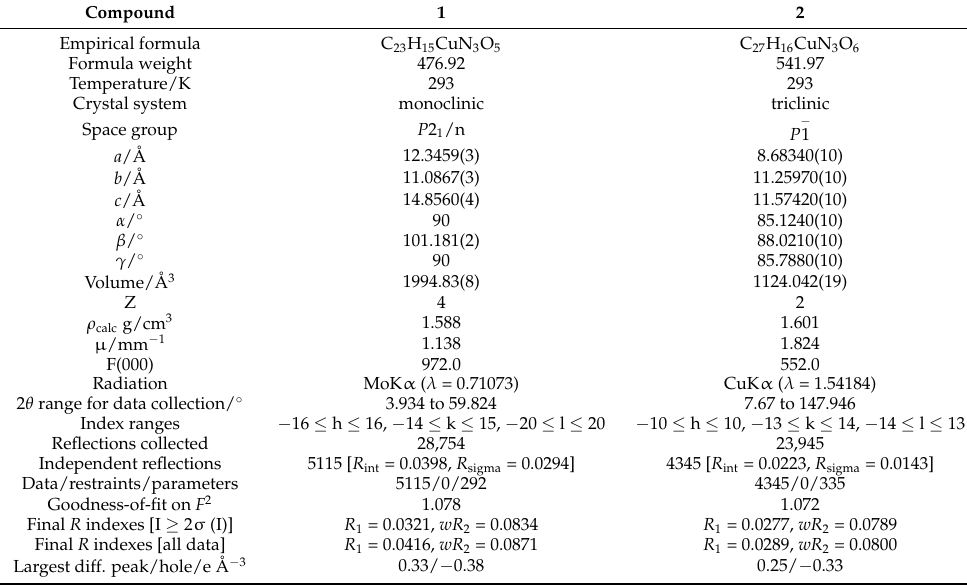
Table 1. Crystal data and structure refinement for 1 and 2 .